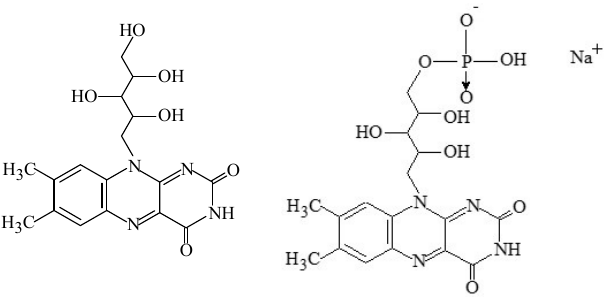
Figure 2. Structural formulae of riboflavin (E101i) and riboflavin-5’-phosphate (E101ii). Nowadays, riboflavin is obtained by chemical synthesis or biotechnological methods, whereas riboflavin-5’-phosphate is produced by chemical synthesis from riboflavin and phosphoric acid. Milk is the main source of riboflavin, but green vegetables and liver also have appreciable